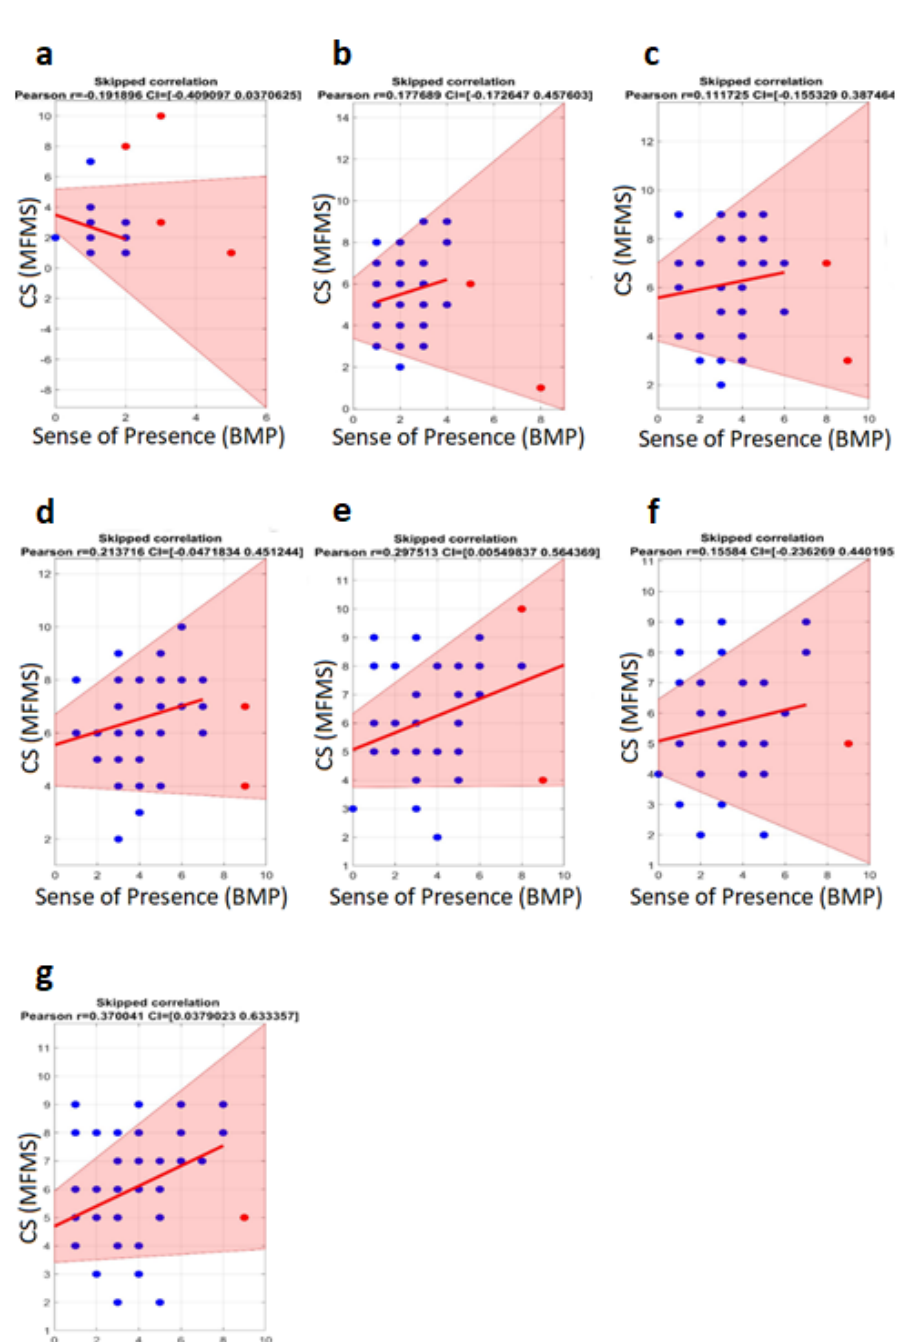
Figure 3. Skipped correlations between MFMS and BMP for each measure in time. Skipped Pearson’s correlations for each measure of MFMS and BMP. The top of the figure shows Pearson’s r coefficients and 95% confidence intervals (shown as the transparent red area in the figure). The numbering above each skipped correlation indicates the time interval. The x -axis represents the score for sense of presence (BMP; 1–10), and the y -axis shows the score for CS (MFMS; 1–10). Dots show each data point, where red dots represent outliers that were eliminated before the correlation analyses were computed. ( a – g ) represent the chronological order in which the questionnaire answers were collected during and after the VR experience.